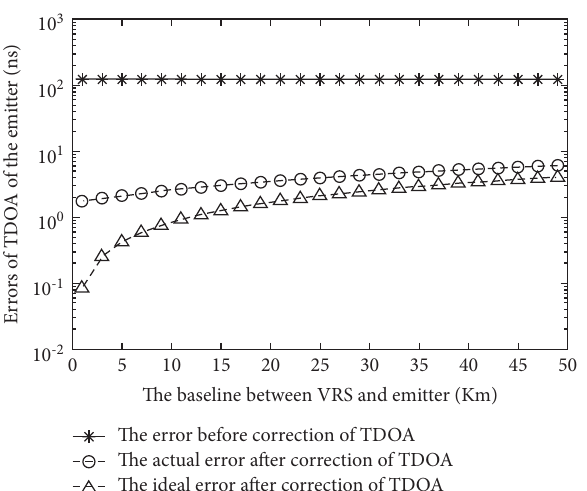
Figure 4: TDOA correcting accuracy of the target with the longer distance between the VRS and the unknown